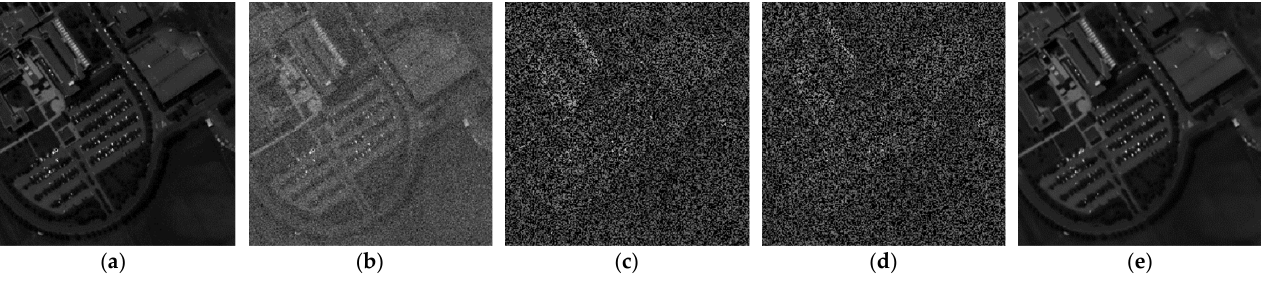
Figure 3. HSI processing process: ( a ) clean HSI; ( b ) simulated noise HSI; ( c ) Bernoulli sampling re- sults as model input; and ( d ) Bernoulli sampling discard result; and ( e ) output result.